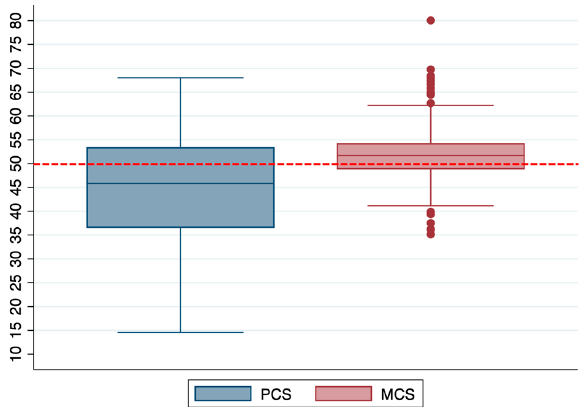
Figure 2. Distribution of the PCS and MCS in the entire population. Box plot shows median and interquartile ranges, while whiskers represent the outliers. The red dotted line represents the value for the normal population.